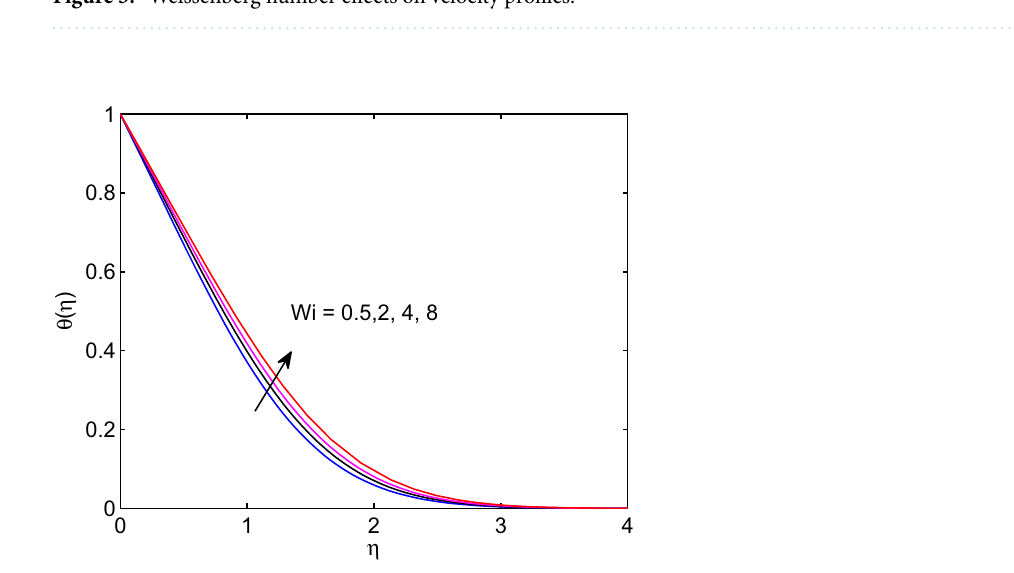
Figure 4. Weissenberg number effects on temperature